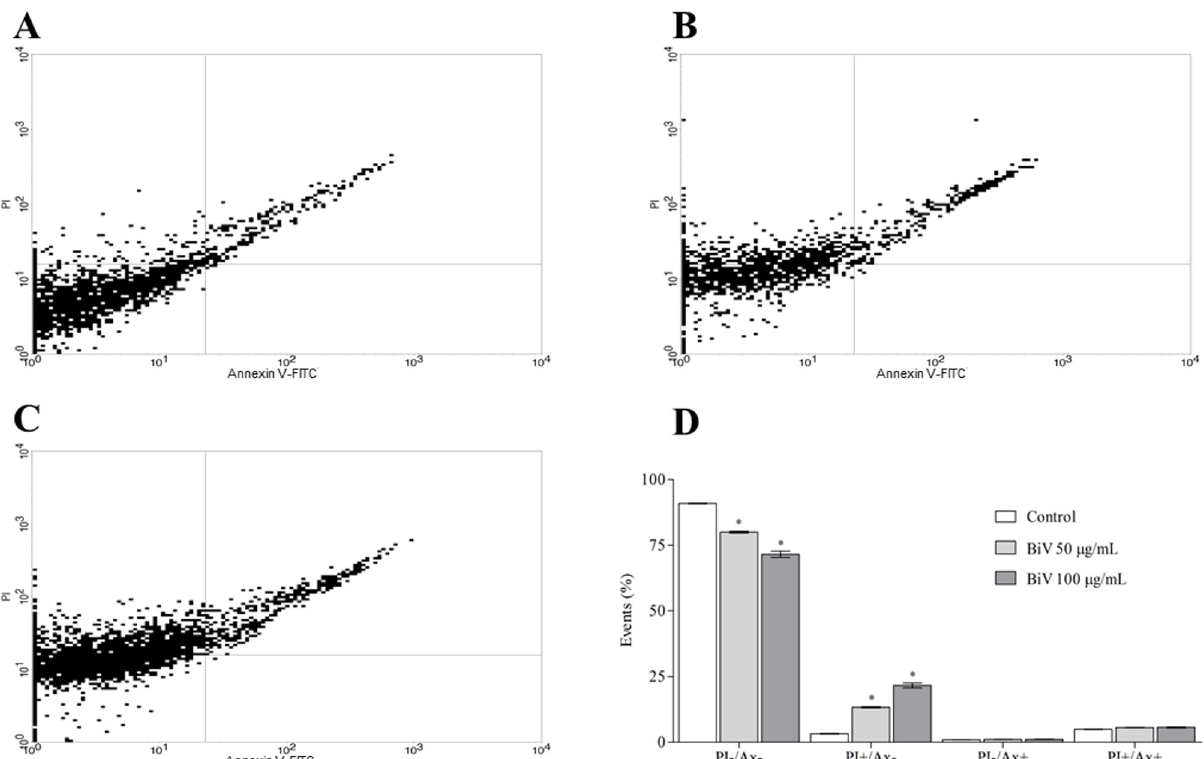
Fig 5. Necrotic potential of BiV on murine macrophages in vitro . [A-C] Dot plot diagrams representing respectively control and groups treated with BiV at 50 μ g/mL and 100 μ g/mL. [D] Increase in the percentage of PI-labeled cells, suggestive of cell death by necrosis. * p < 0.05 vs. control